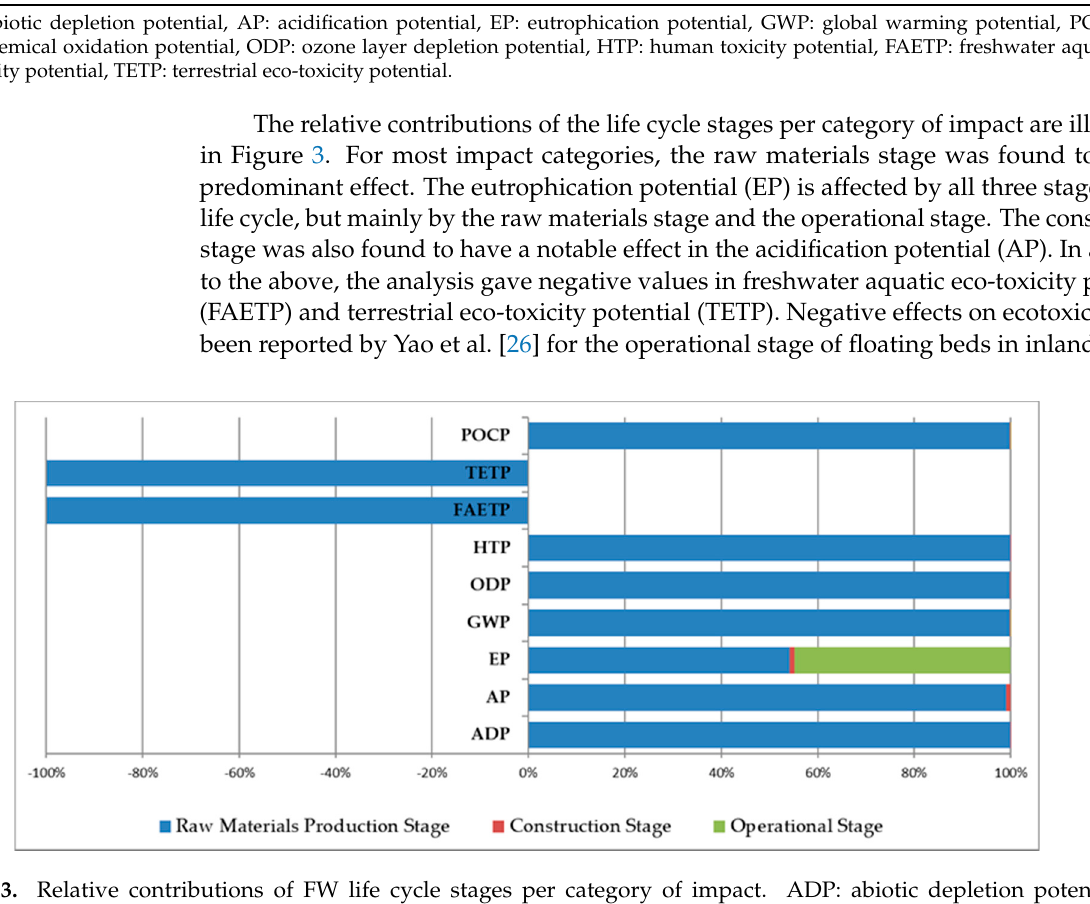
Impact Categories